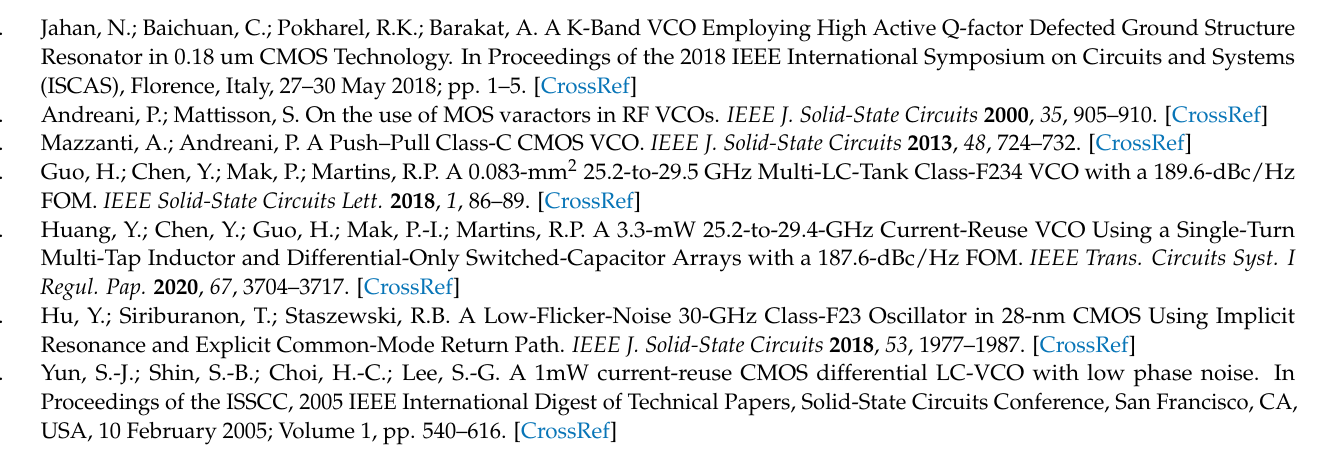
Figure 13. FoM and FoM T vs. frequency. Table 1. Performance summary of different VCOs.